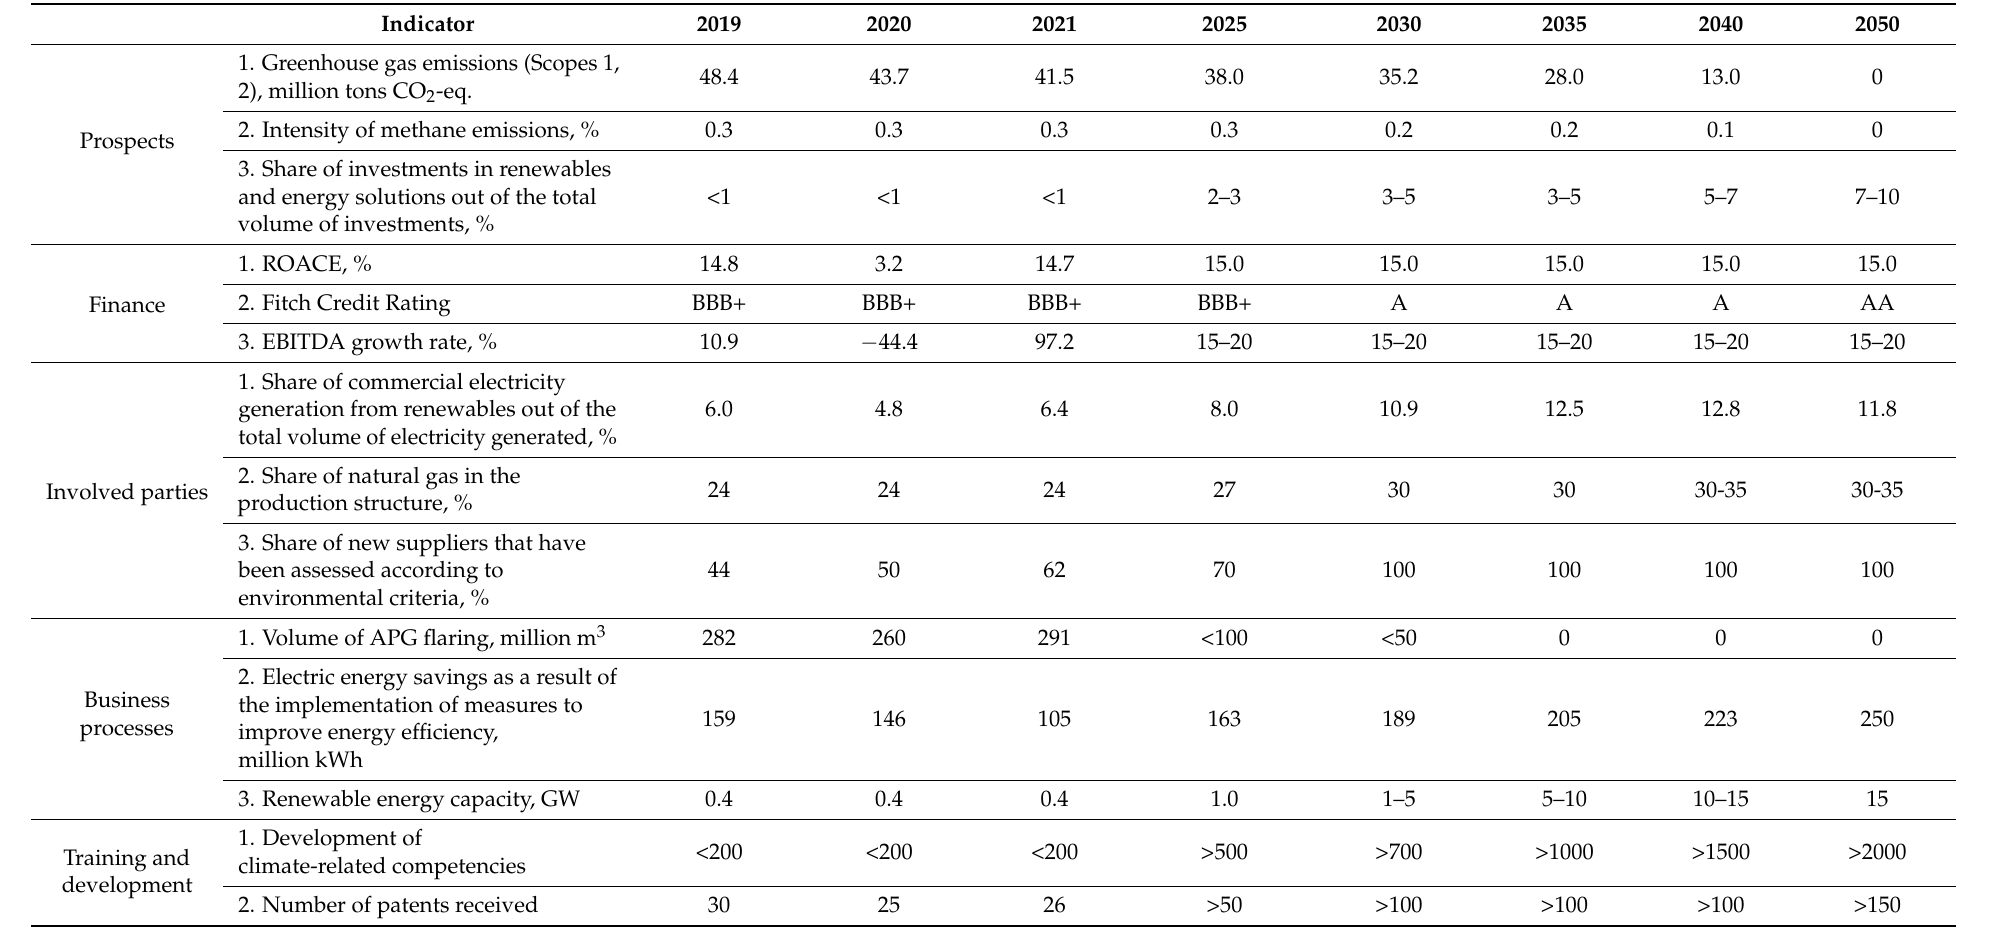
Table 3. LUKOIL’s Balanced Scorecard for climate